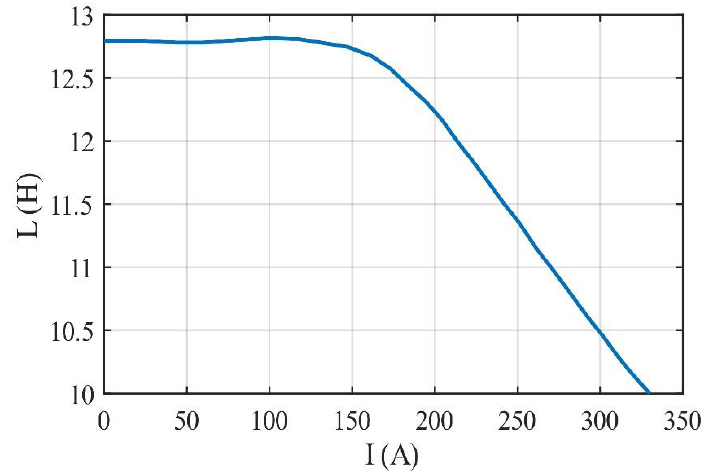
Figure 3. Coefficient of self-inductance over transport current curve for the EcoSwing rotor, derived based on the information in [5].